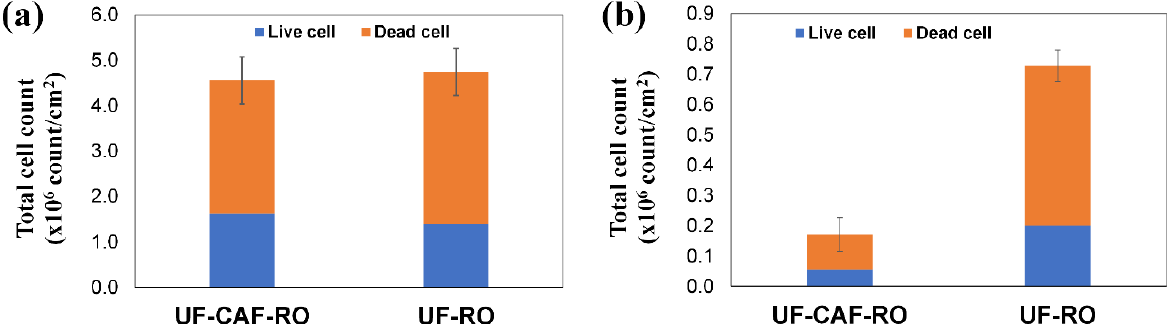
Figure 6. Live/dead cell count on the fouled RO membranes with and without CAF pre-filtration in the ( a ) 1st evaluation and ( b ) 2nd evaluation.